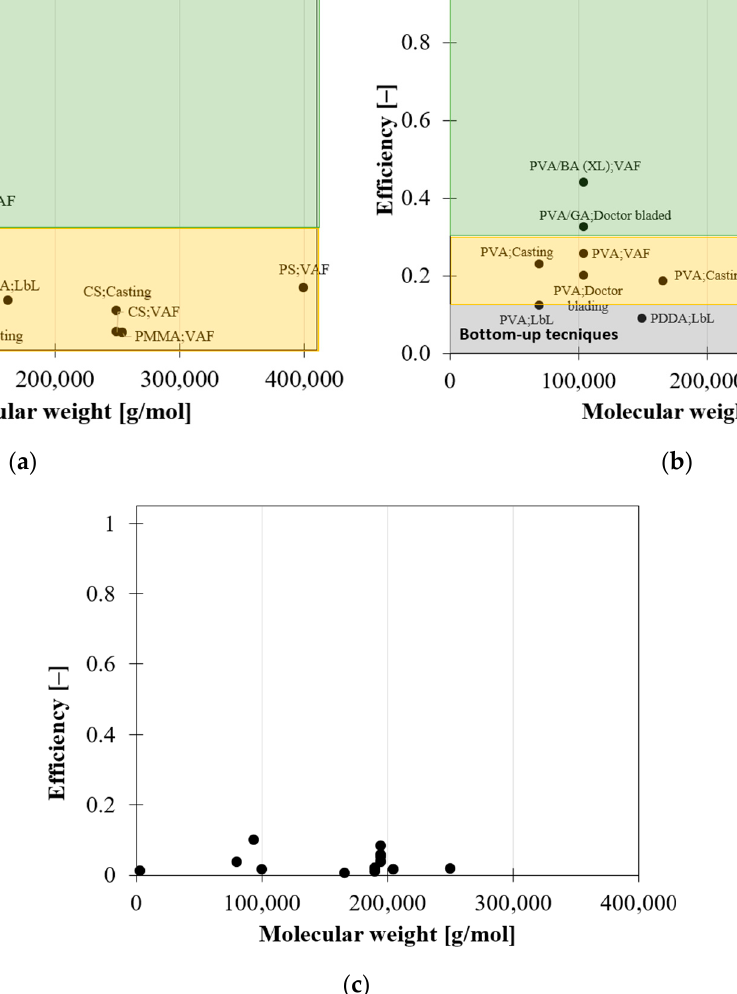
Figure 6. Efficiency of reinforcement vs. molecular weight for composite reinforced with: ( a ) MTM; ( b ) GO; ( c ) RGO.